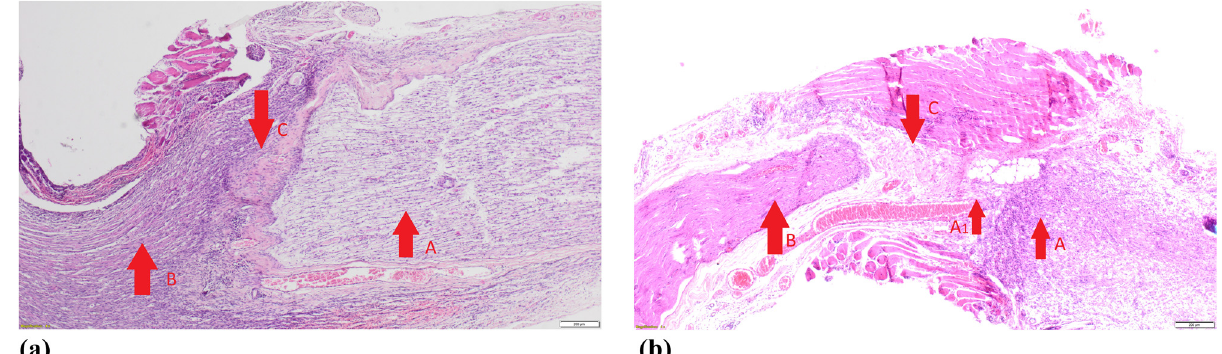
Figure 3: Pathomorphological examples of a side - to - side ( a ) and an end - to - end ( b ) nerve